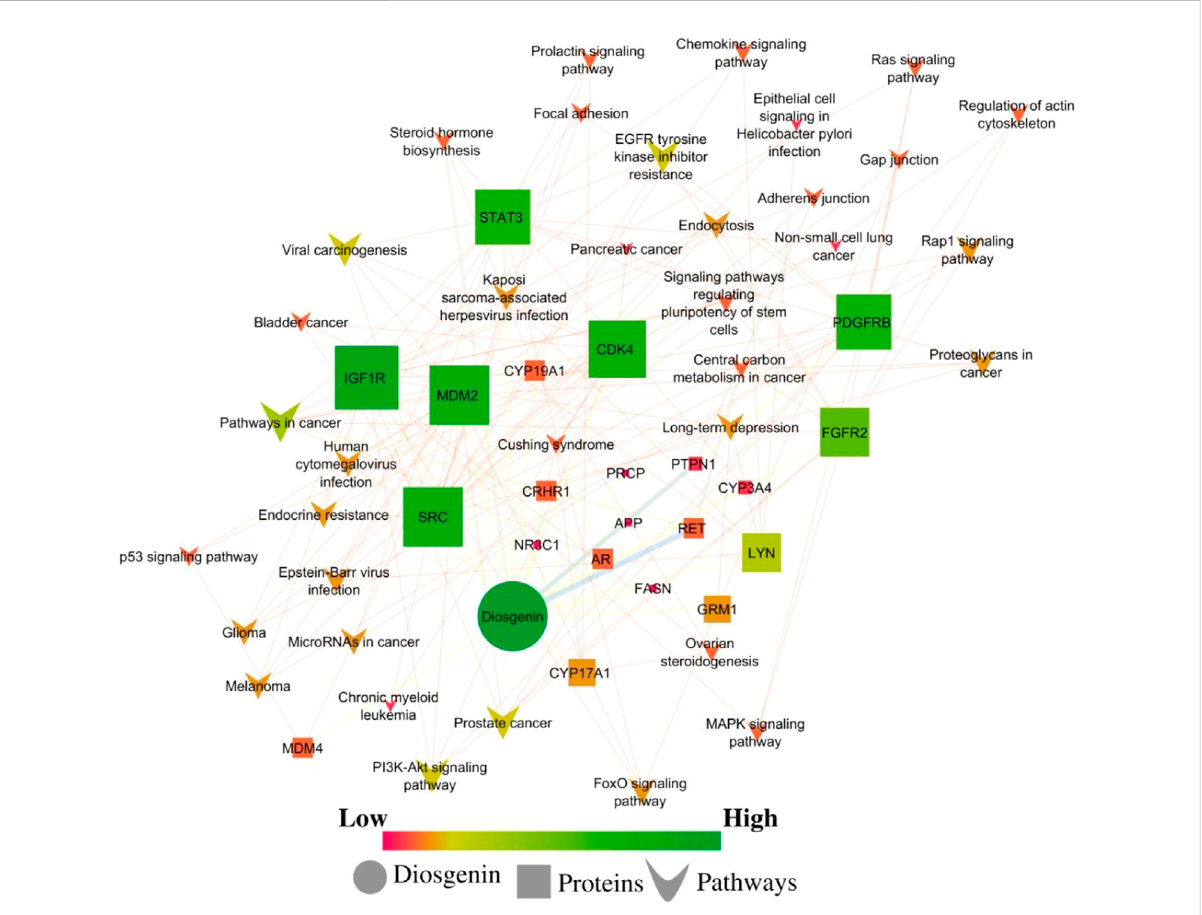
FIGURE 3 Networkinteractionofdiosgenin-regulatedproteinsandrespectivepathways.Pinkcolorpresentsalowedgecountandgreencolorpresentsa high edge count. A large node size presents a higher edge count and a smaller edge count presents a lower edge